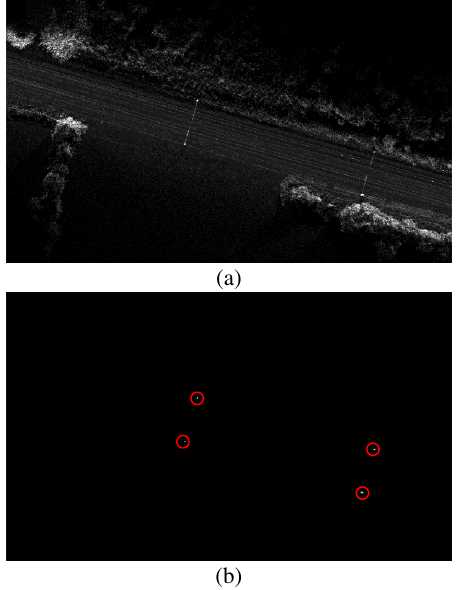
Figure 3. Example of candidate extraction: (a) planar point density (b) extracted